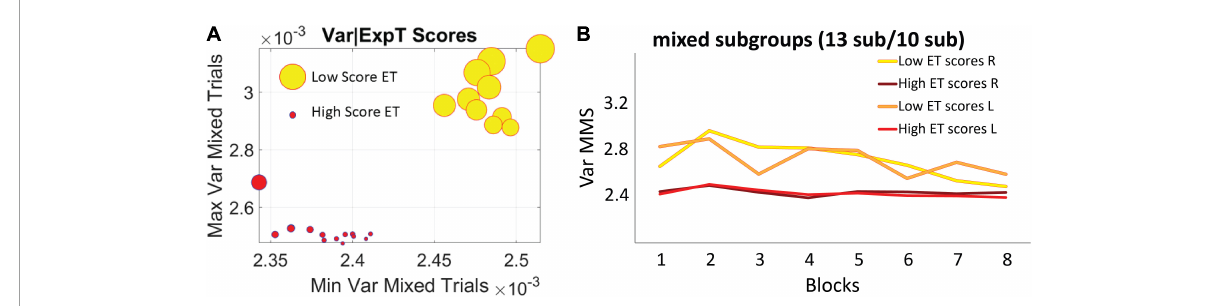
FIGURE7 Self-emerging subgroups in the mixed group are differentiated by the scores of the explicit memory test. (A) The horizontal axis comprises the minimum value of the variance, while the vertical axis comprises the maximum value of the variance for each participant. Thus, the graph depicts the full range of variance values. The size of the marker is proportional to the explicit memory test score and the color represents the subgroup, with no overlapping between the two sets of participants. (B) Empirically estimated Gamma variance parameter unfolded block by block as in Figures 6A,B , for the two subgroups of the mixed condition. The group with less explicit knowledge [lower scores on the explicit memory test (ET score M = 0.94, SD = 0.4)] starts out with higher variance of the fluctuations of the MMS amplitudes (broad-variance group A), eventually converging to the much lower variance level of the subgroup that showed higher explicit knowledge of the regularity (ET score M = 1.52, SD = 0.75) (narrow-variance group B).